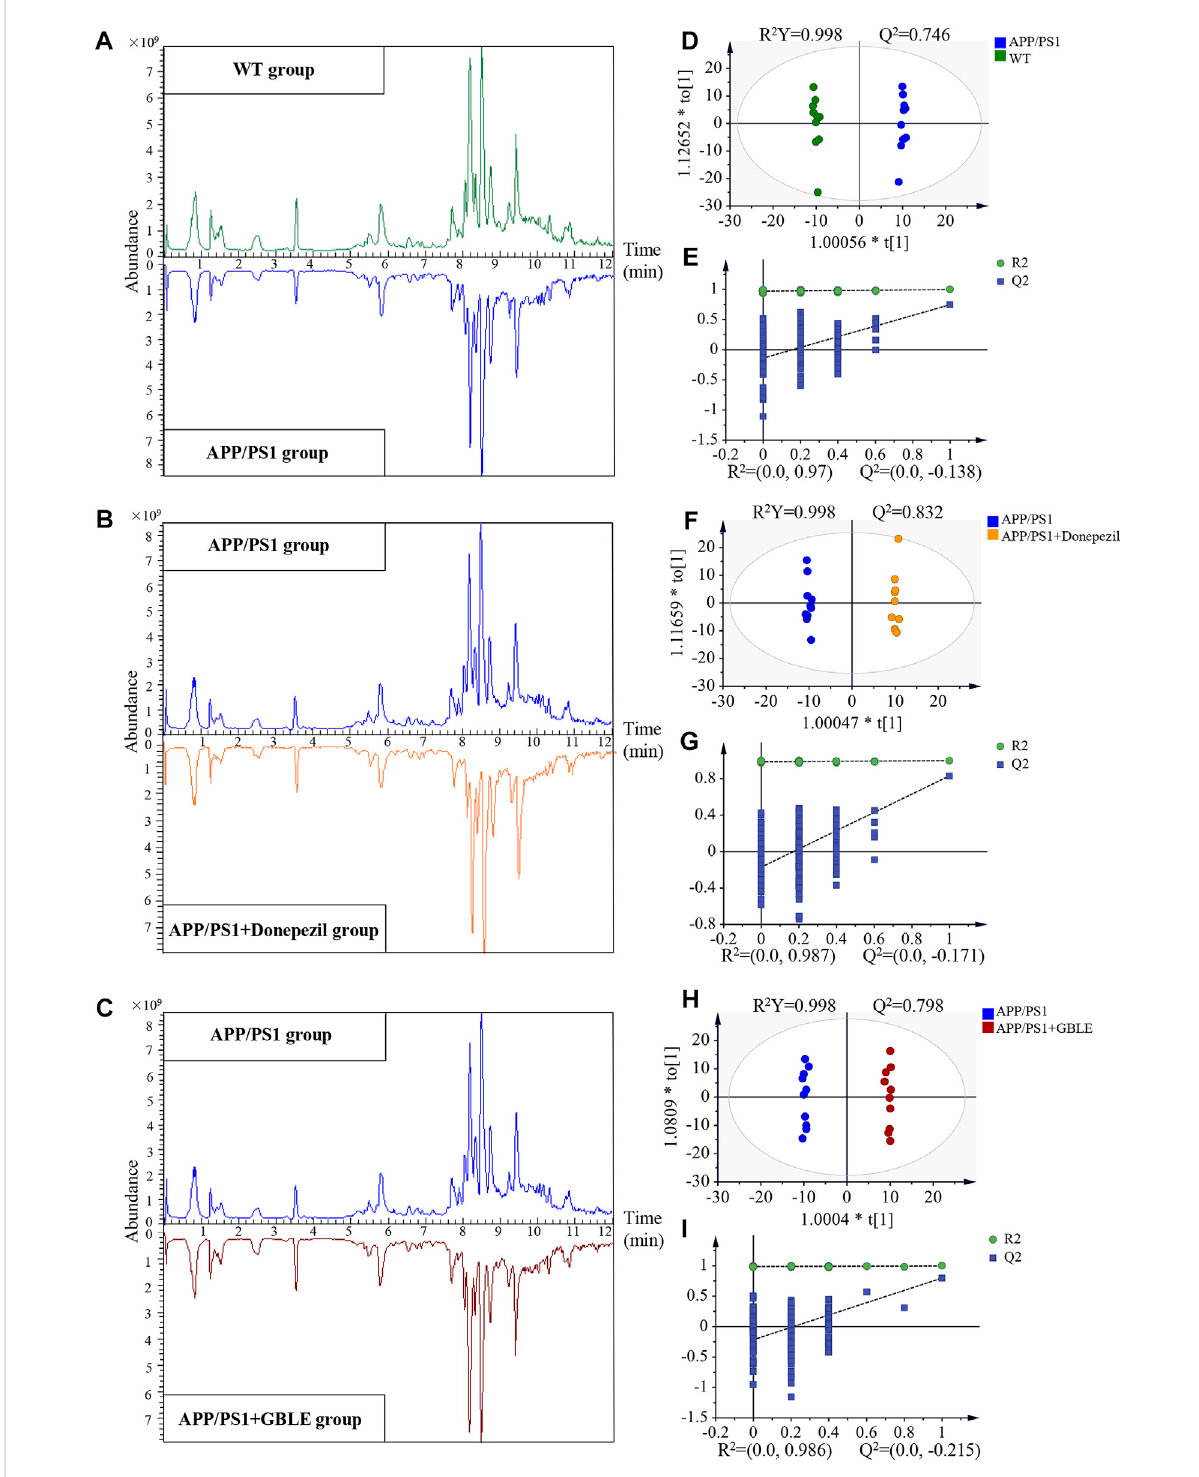
UHPLC-Q-Orbitrap HRMS-based untargeted metabolomic analysis . (A,B,C) Comparisons of representative total ion chromatograms for plasma samples from WT, APP/PS1, APP/PS1+Donepezil, and APP/PS1+GBLE groups in positive ion mode. (D,E) OPLS-DA score plots and corresponding permutation tests for APP/PS1 vs. WT in positive ion mode. (F,G) OPLS-DA score plots and corresponding permutation tests for APP/ PS1+Donepezil vs. APP/PS1 in positive ion mode. (H,I) OPLS-DA score plots and corresponding permutation tests for APP/PS1+GBLE vs. APP/ PS1 in positive ion